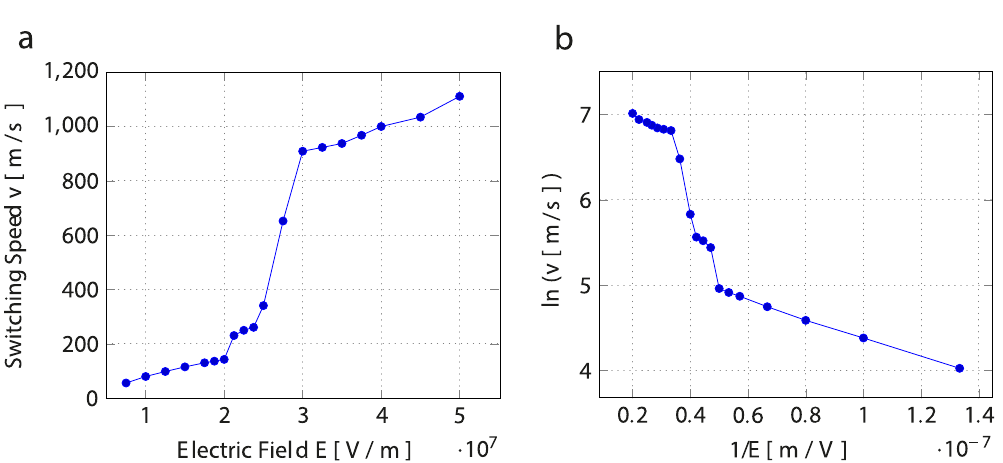
Figure 7. Average domain switching speed at various electric field values. ( a ) Plot of switching speed (v) versus electric field (E) showing a jump around 25 MV/m. ( b ) Plot of ln(v) versus 1/E shows a negative linear relation describing a creep process at low electric field